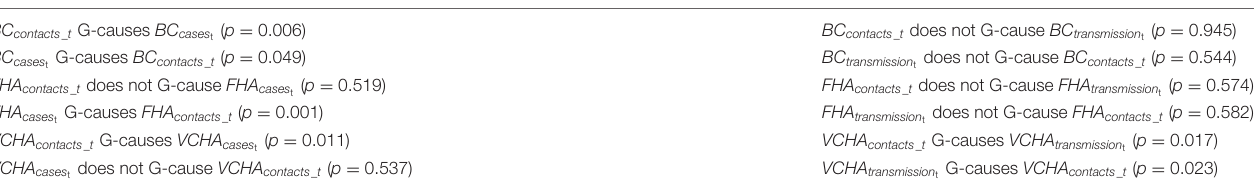
TABLE 2 | Granger causality test results for average daily contacts and average daily cases and average daily contacts and transmission, in BC and two health regions, FHA and VCHA. BC contacts _ t G-causes BC cases ( p = t